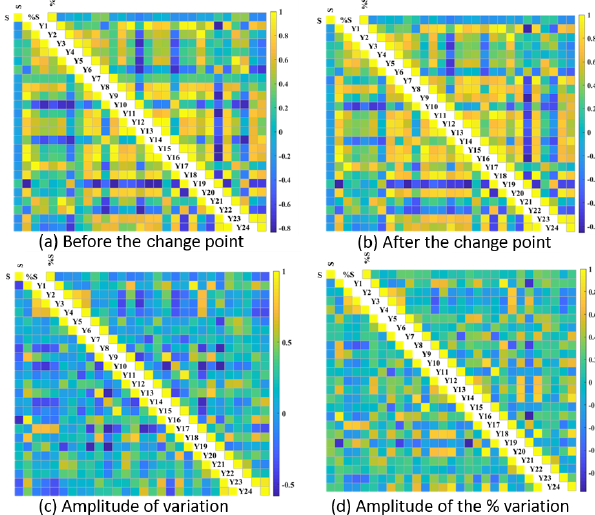
Figure 7. Pearson correlation coefficient based on the association between the magnitude of the shift in θ 1 and multiple catchment properties as well as the associations between different catchment properties. In the lower triangular matrix, the shift in θ 1 was con- sidered, while in the upper triangular matrix, the percentage shift in θ 1 was used. S denotes the shift in θ 1 , and % S denotes the per- centage shift in θ 1 , while X1–X9 denotes the catchment properties mentioned in Table 2.